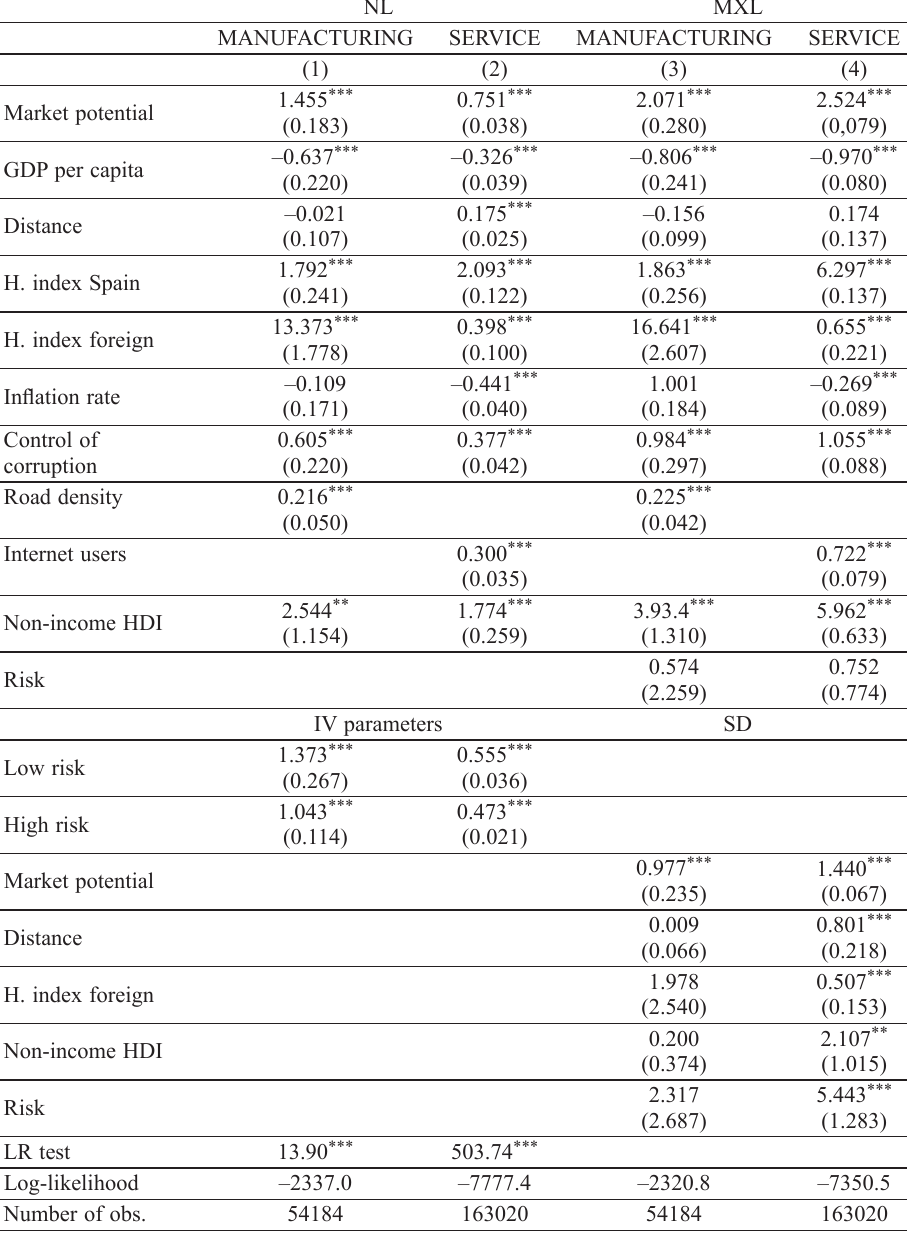
Table 2. Regression results from nested and mixed logit